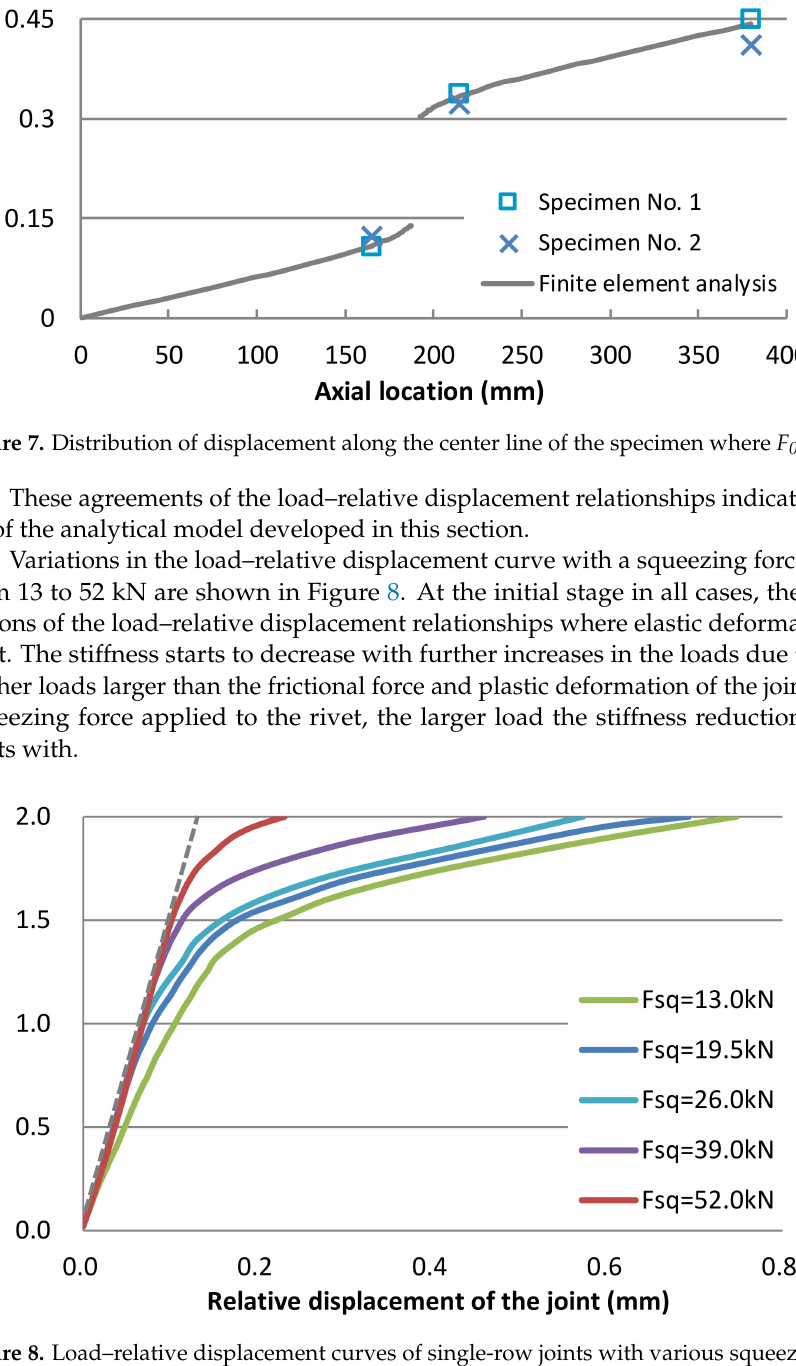
Figure 8. Load–relative displacement curves of single-row joints with various squeezing